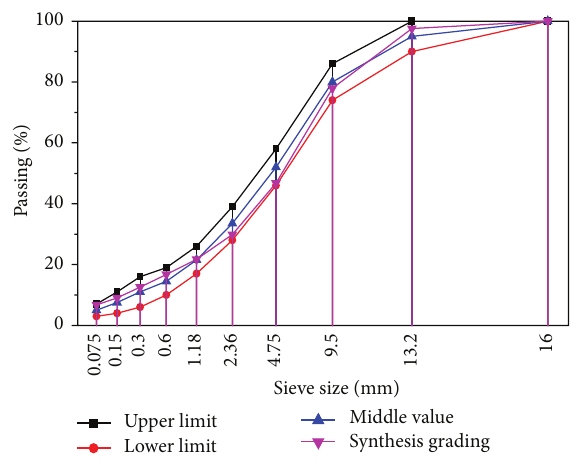
Figure 1: Mixture